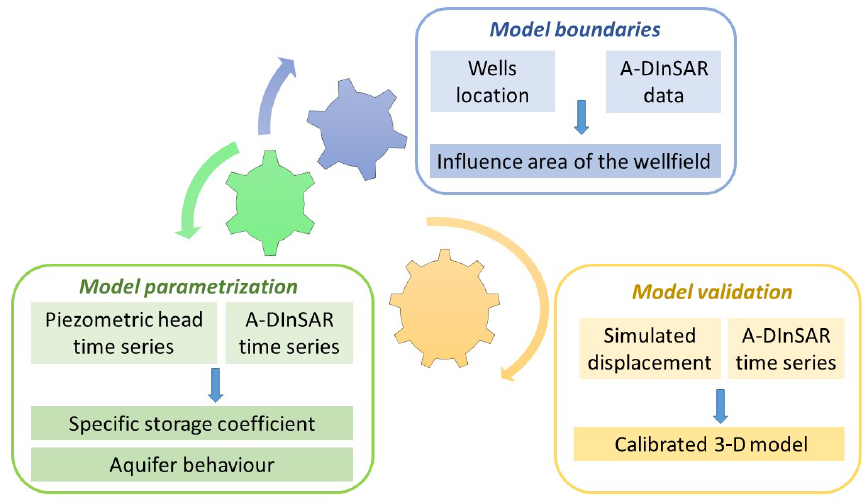
Figure 4. Schematic overview of the integrated approach used to reconstruct the 3-D model with the support of A-DInSAR data.